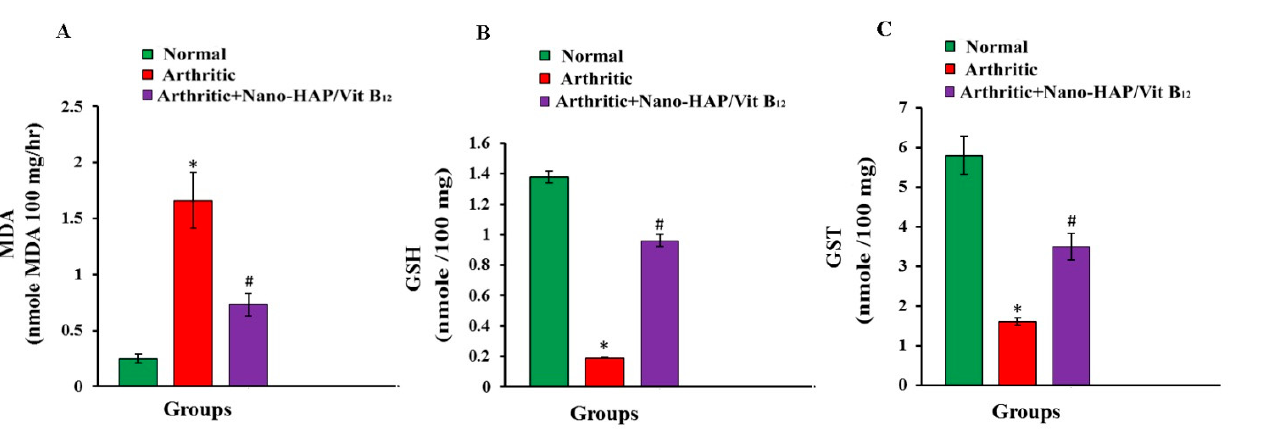
Figure 6. Effect of Nano-HAP/Vit B 12 on ( A ): LPO, ( B ): GSH content, and ( C ): GST activities. Data are expressed as mean values ± SEM (* p < 0.05: significant difference relative to arthritic group, # p < 0.05: significant difference relative to arthritic rats treated with Nano-HAP/Vit B 12